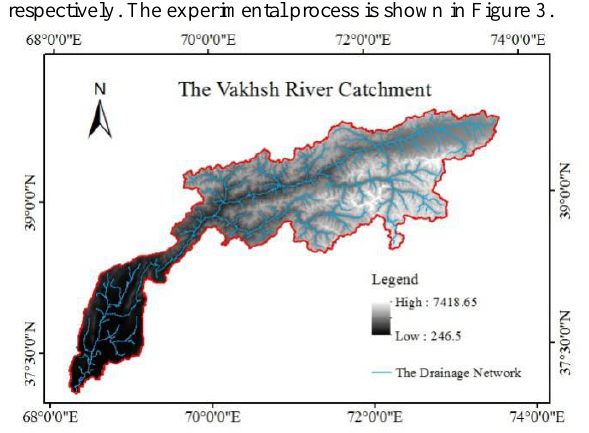
The frequency of catchment boundary spectrum is the ratio of the number of wave crest and wave trough to the sample